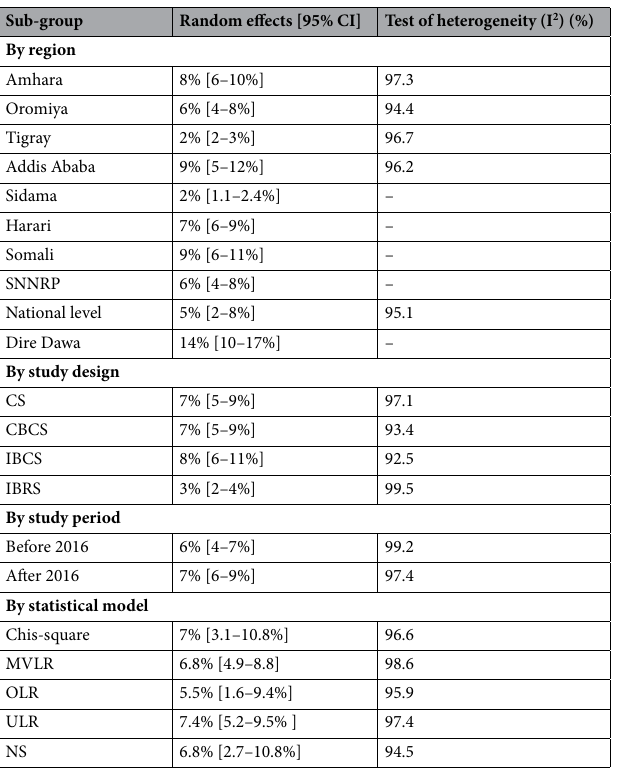
Table 3. Sub-group analysis of studies included in the meta-analysis on the prevalence and associated factors of DM in